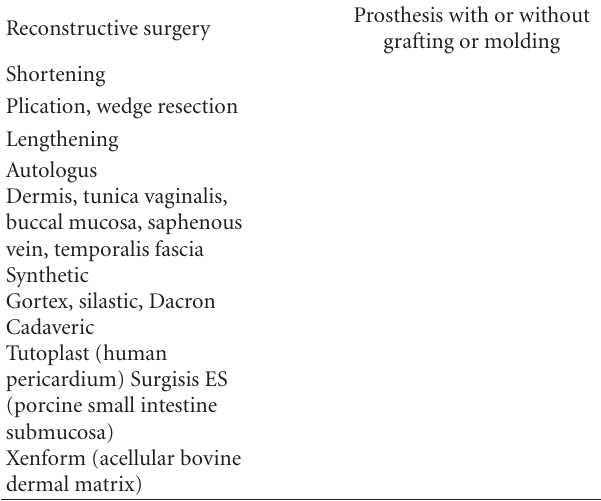
Reconstructive surgery